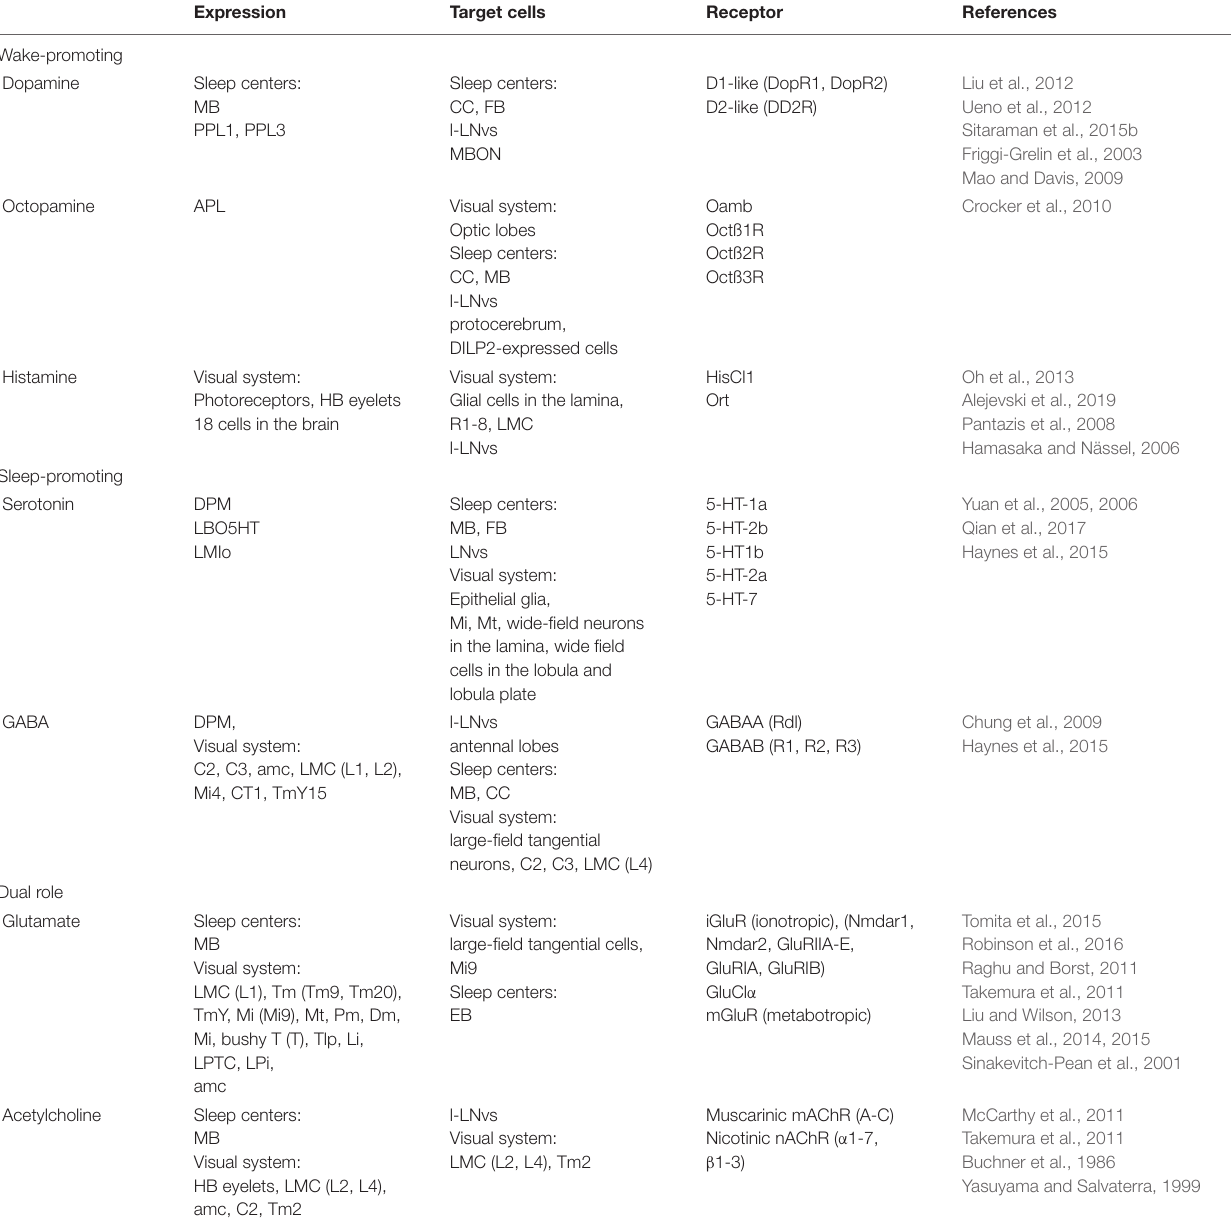
TABLE 1 | Neurotransmitters involved in sleep